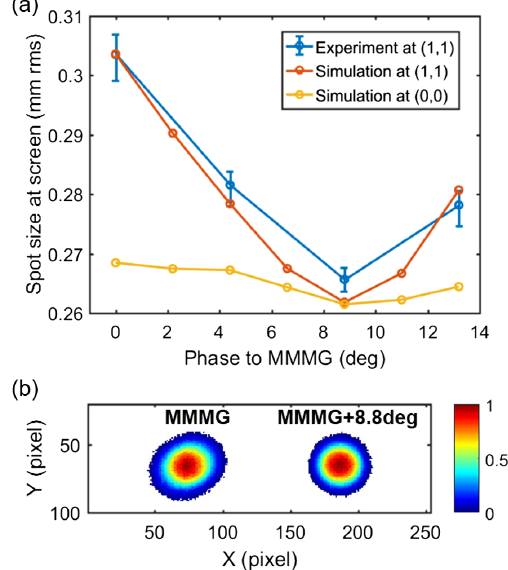
FIG. 2. (a) Minimization of rf induced emittance growth for the off axis beam by a special rf phase. The off axis laser position is (1,1) relative to the cathode center with units of millimeter. (b) Off axis electron beam images measured at gun phases of MMMG and MMMG þ 8 . 8